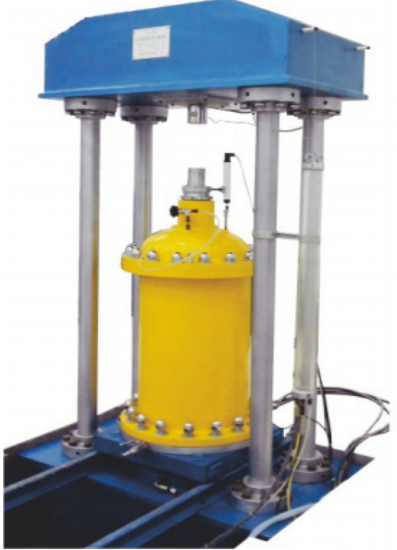
Figure 2. SZ30-4DAD large static triaxial test equipment.